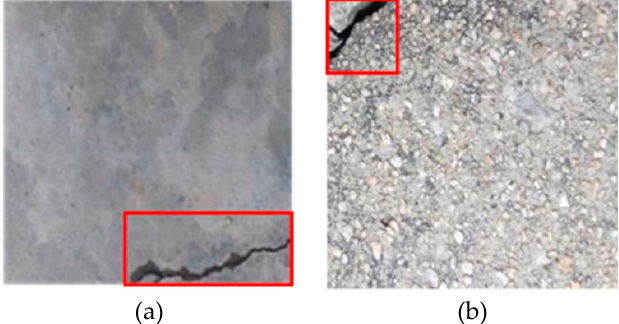
Figure 2. Examples of images with edges containing cracks. ( a ) a picture of the crack in the lower right corner, ( b ) a picture of the crack in the upper left corner.